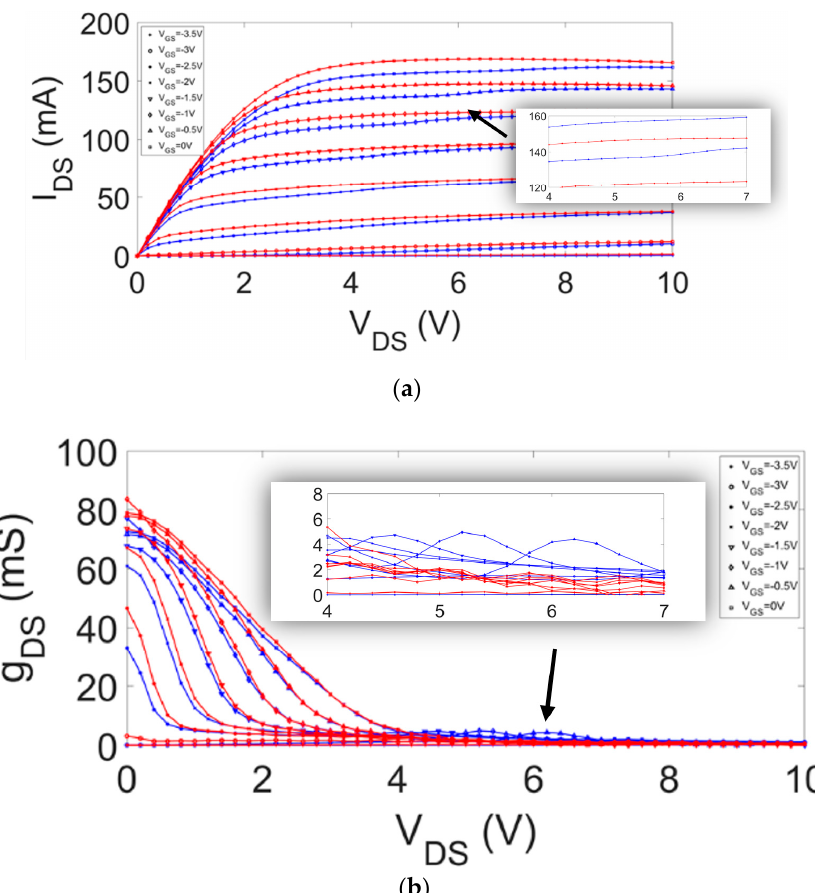
Figure 3. ( a ) I DS and ( b ) g DS versus V DS with V GS from − 3.5 V to 0 V (step 0.5 V) measured for the 200 µm HEMT without (blue line) and with (red line) laser exposure.